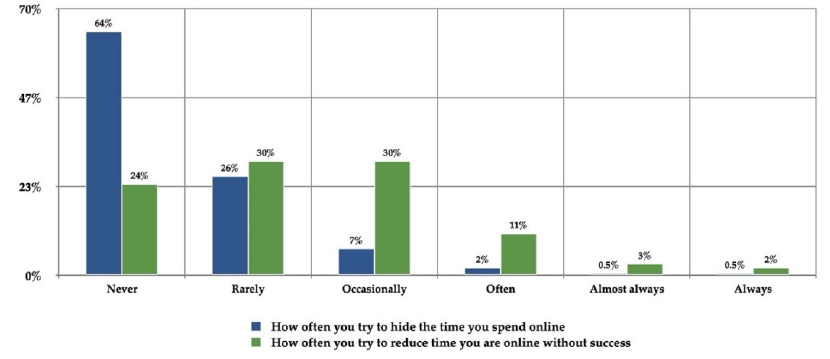
Figure 9. How often you try to hide and reduce the time you spend online.